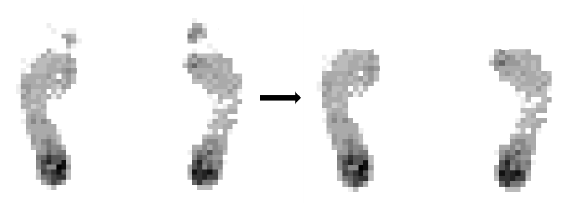
Figure 5. Result of removing the toe part data.